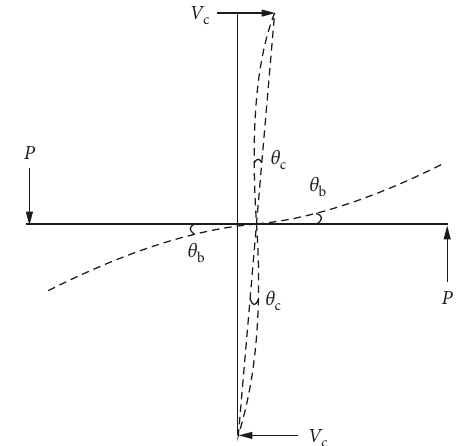
Figure 1: Mechanical model of beam-column